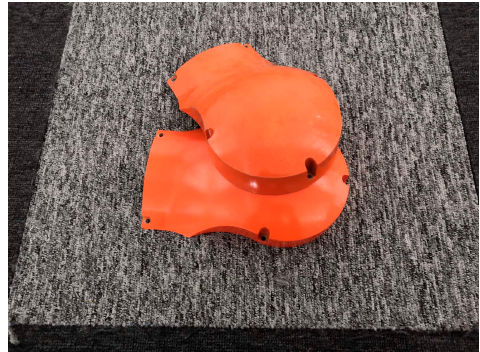
Figure 11. Two of the same workpieces overlapping, resulting in difficulty segmenting the point clouds in three-dimensional (3D) space.